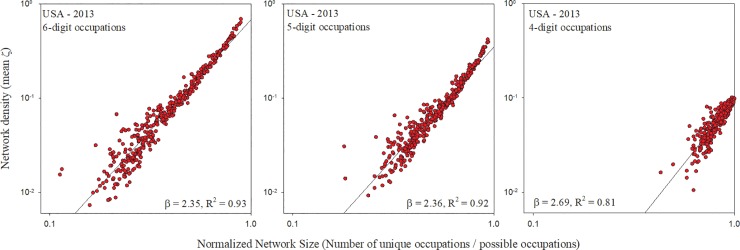
Occupational network size vs. density for U.S. cities at different employment aggregation levels.When occupational network size is compared to its density, the resulting scaling exponents differed little when 2013 U.S. employment is aggregated at the 6-digit, 5-digit, or 4-digit occupation code. The number of distinct occupations in each case are 812 (6-digit), 455 (5-digit), and 107 (4-digit). Note that, for comparability, network size has been normalized by maximum possible size.